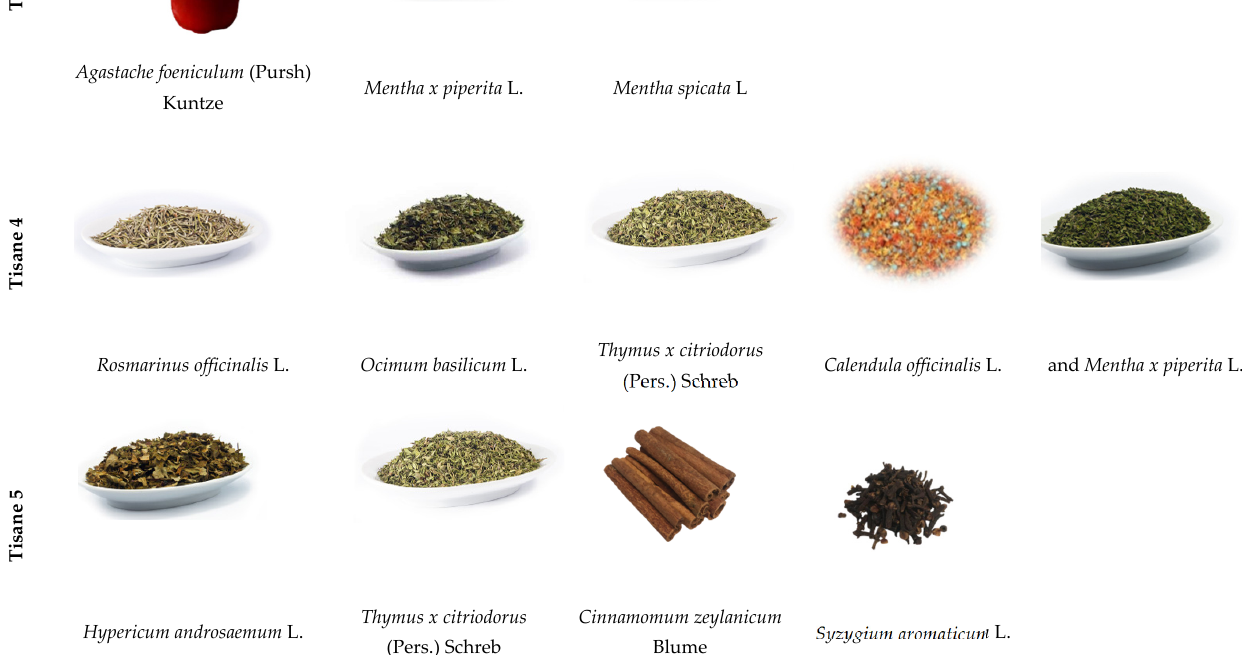
Figure 1. Description of the medicinal and aromatic plants (MAPs) that constituted the five samples tisanes. Table 1. Applicability, common uses, and biological properties of the MAPs that constituted the five samples tisanes. Plant